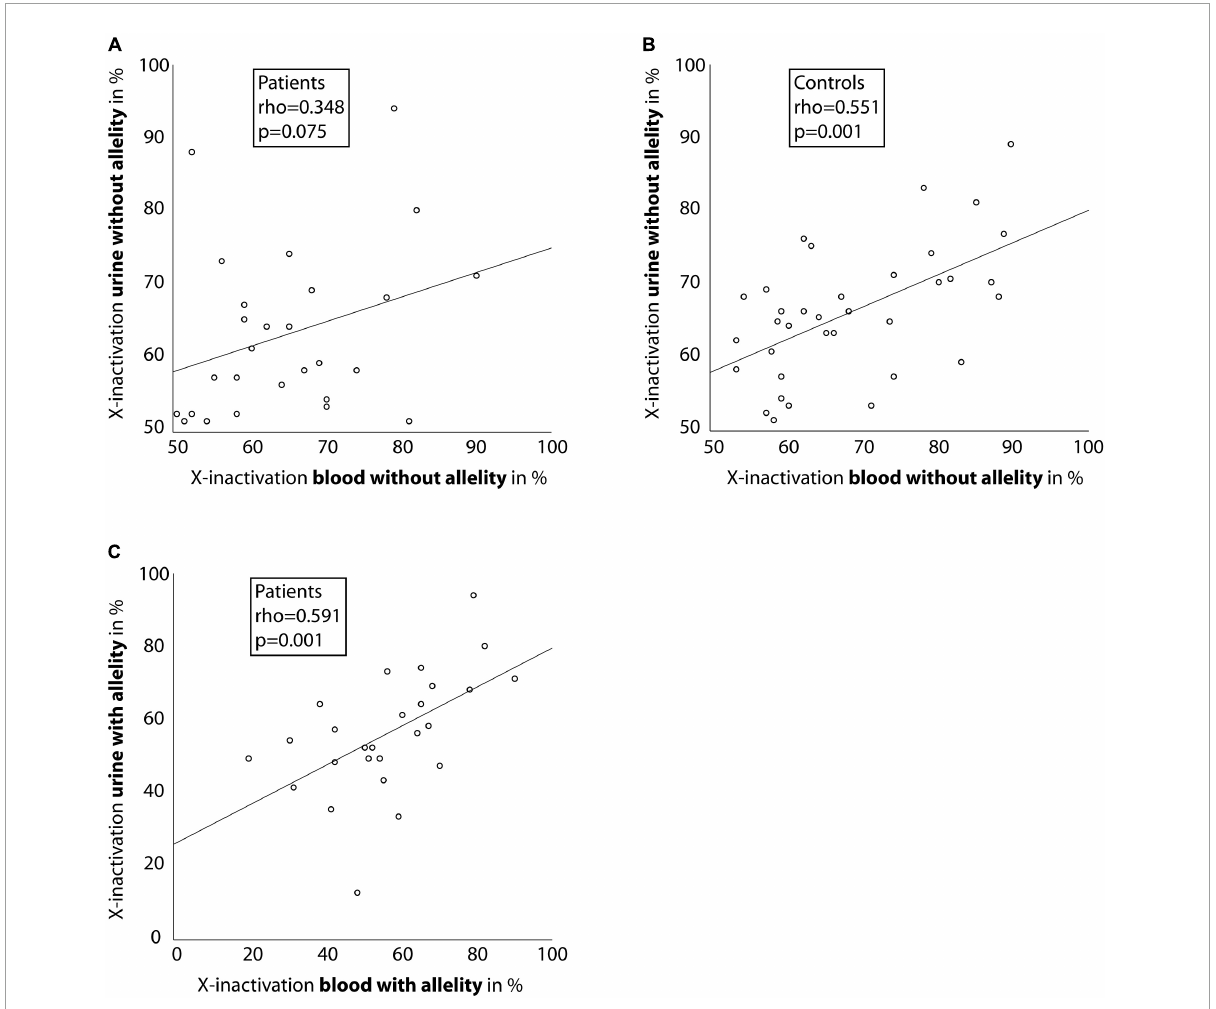
FIGURE2 Correlation between X-inactivation in blood and urine cells. Scatter-dot plots of the relationship of X-inactivation between blood and urine cells for individuals with a heterozygous disease-causing COL4A5 variant (A,C) and healthy controls (B) . Spearman’s rho was calculated and is displayed in the boxes. Linear regression lines were plotted for illustration